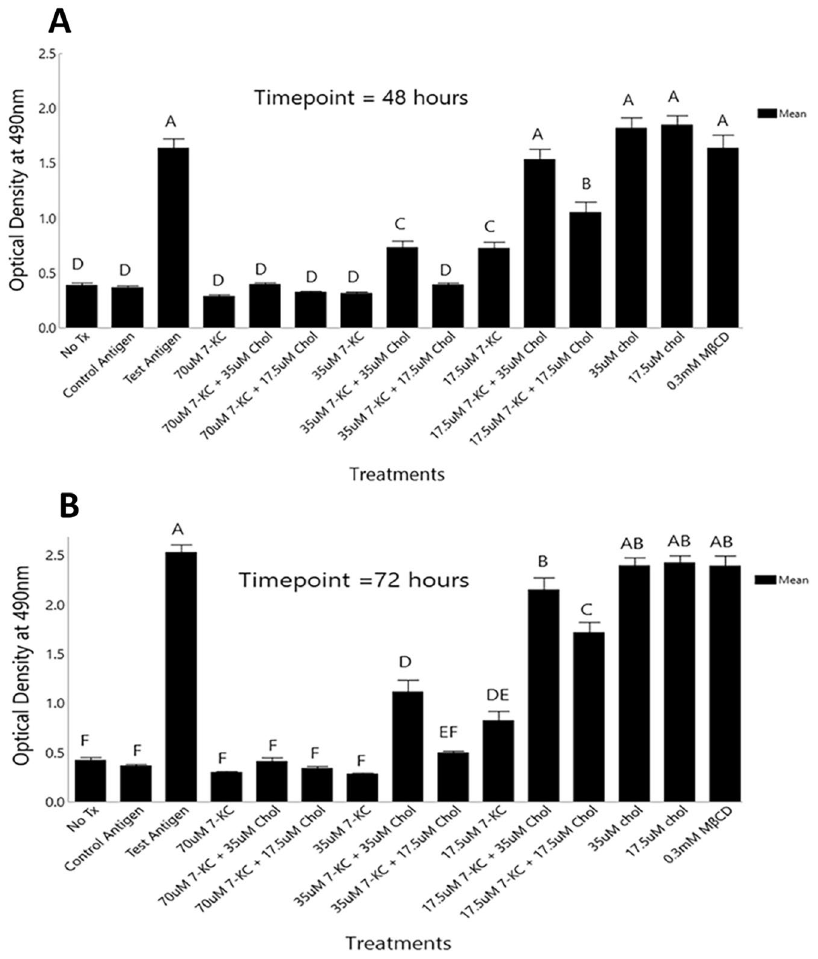
Figure 2. Antigen-specific proliferative responses by CD4 + T cells with ordered and disordered membranes. Lymph node cells were treated with different concentrations of 7-KC-MβCD complex and/or different concentrations of Cholesterol-MβCD complex and MβCD-vehicle control for 10 min at RT. Proliferative response to stimulatory peptide c-Ova 323–339 or a control peptide c-Ova 324–334 were examined after 48 ( A ) and 72 ( B ) hours of incubation at 37 °C incubator. 20 µl of MTT reagent was added to the cell cultures and incubated over the last 4 h of the total incubation time. Optical density of each culture well, that was reflective of the antigen specific CD4 + T cell proliferative response, was read at 490 nm using a 96 well plate reader. All data were computed from 5 independent trials. Error bars represent Standard Error. Statistical significance between the groups was computed by two-way ANOVA and post hoc Tukey analysis using JMP program. Groups with dissimilar connecting letters are significantly different (p < 0.05) from each